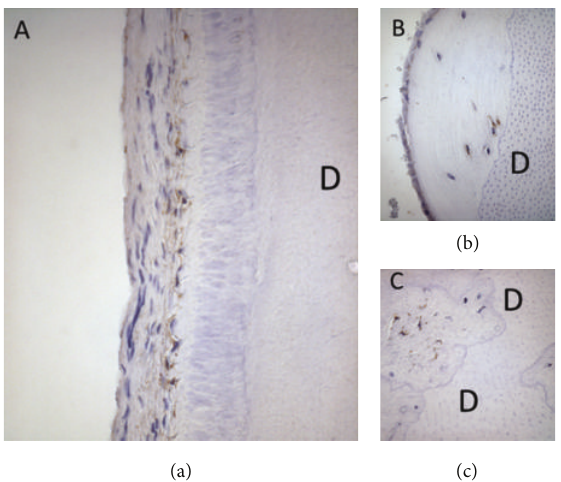
Figure 12: Three immunohistochemical sections of NeuN (nerve tissue markers) shown on otherwise uncoloured sections. D marks the dentin. Left: normally developed root surface (brown nerve cells) [89, 103]. Right: two sections of tooth root surfaces from teeth extracted due to arrested eruption. Upper: root dentin covered in hypercementosis-like tissue formations. Below: an unorganized pattern of dentin and bone tissue with nerve markings. It must be presumed that the very uneven surface dentin in the two images to the right is caused by resorption and that the resorption lacunae are later filled with tissue with osteogenic